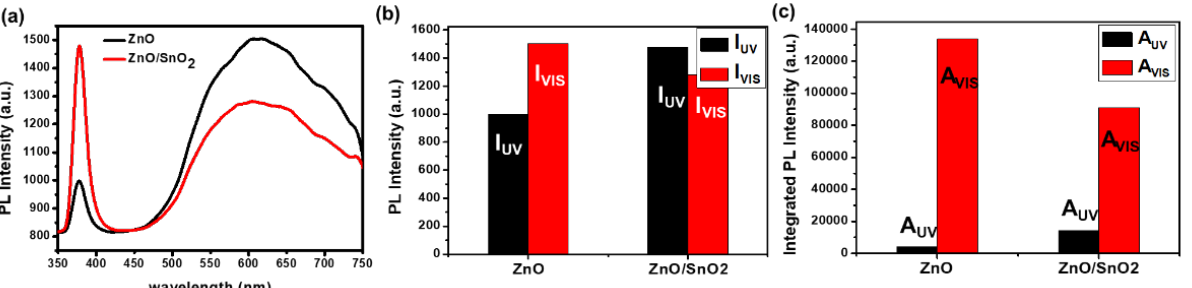
Figure 8. ( a ) Photoluminescence spectra of ZnO NRs, and ZnO/SnO 2 NRs. ( b ) The intensity ratio of the UV and visible luminescence of ZnO and ZnO/SnO 2 PDs and ( c ) the integrated intensity ratio of the UV and visible luminescence of ZnO and ZnO/SnO 2 PDs.